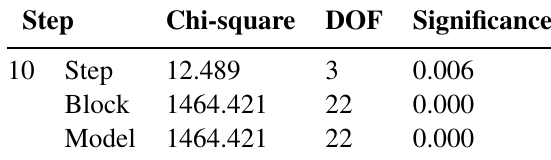
Table 2 Omnibus test of binary logistic regression model coefficients.